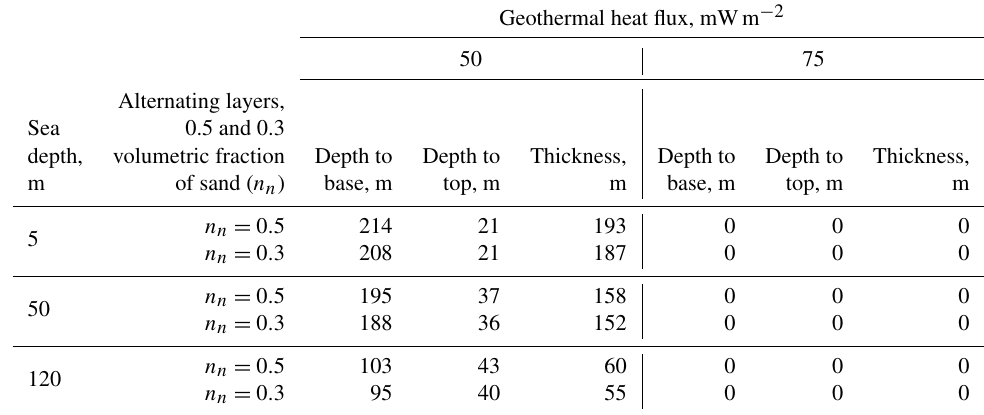
Table 7. Modeling results for depths to permafrost top and base and permafrost thickness for 50m of alternating sand and clayey silt (clay) layers lying over bedrock, NE